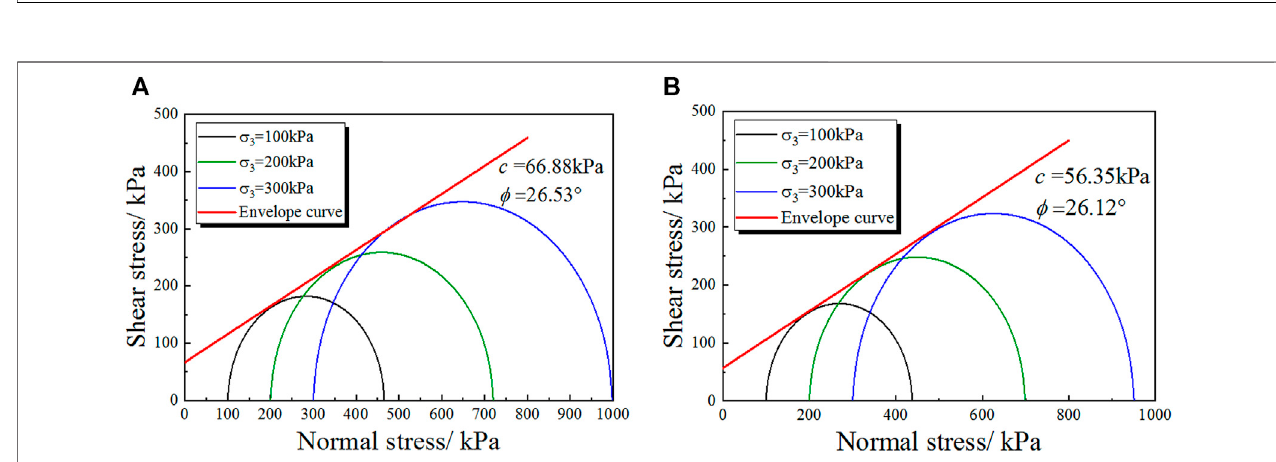
FIGURE 4 | Mohr-Coulomb failure envelope curves: (A) original specimens; (B) F-T specimens.